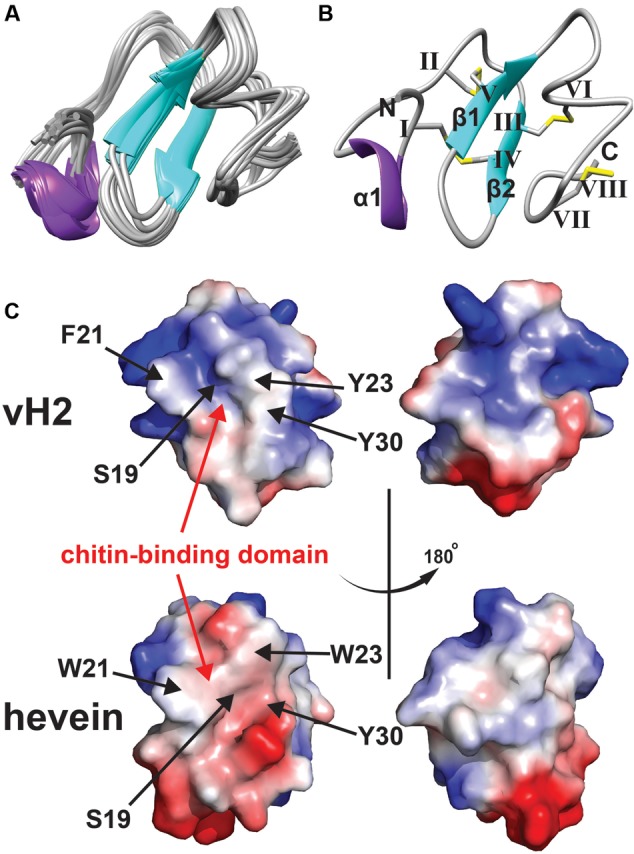
Solution NMR analysis of vH2. (A) Superposition of the vH2 backbone traces from the final 20 ensembles solution structures and restrained energy minimized structure. (B) Ribbon representation of vH2 structure solved by NMR. The disulfide connectivity is as follows: CysI–CysIV, CysII–CysV, CysIII–CysVI and CysVII–CysVIII. (C) Topology comparison of electrostatic surface between vH2 (PDB: 5XDI) and hevein (PDB: 1HEV) in two views revealing the chitin-binding domain. The distribution of electrostatic charges was displayed in red (negatively charged), blue (positively charged) and white (neutral). The residues (vH2: S19, F21, Y23, and Y30; hevein: S19, W21, W23, and Y30) within chitin-binding domain have been shown to play an important role in binding towards chitin.